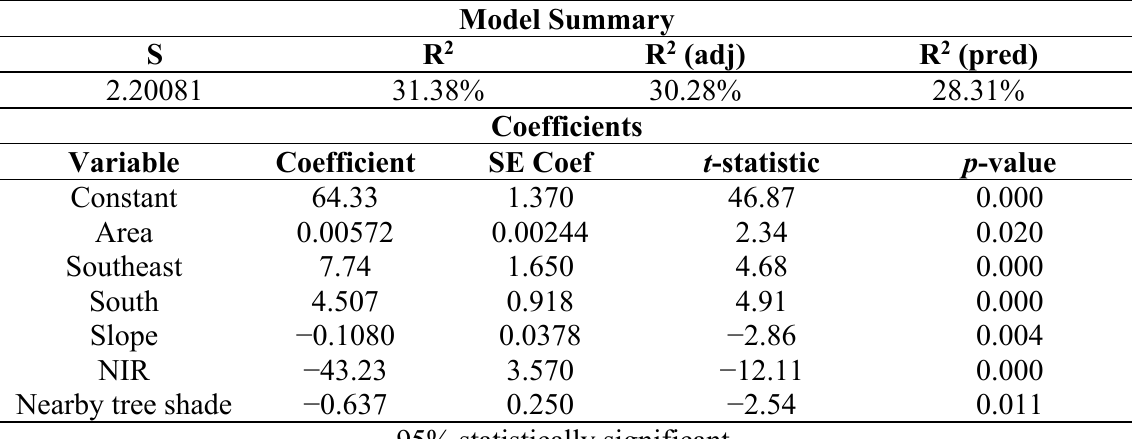
Table 7. Daytime regression analysis results by NIR reflectance.